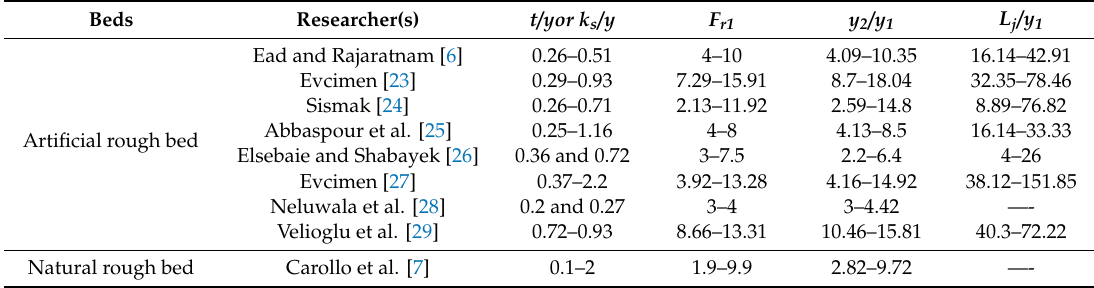
Table 1. Summarized characteristics of the experiments for both natural and artificial rough